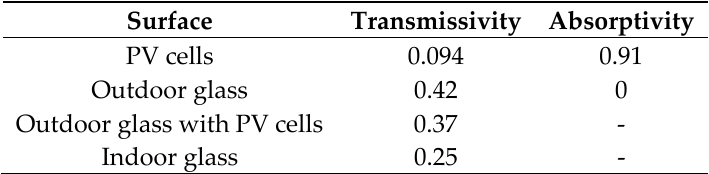
Table 2. Radiative properties measured in the façade.